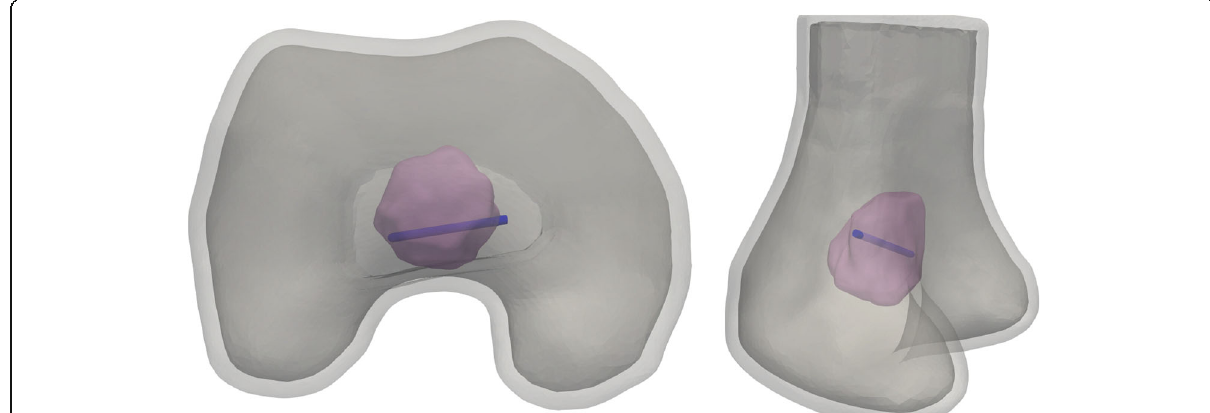
Fig. 3 Example of the resulting three-dimensional models from the image segmentations. The electrode is shown in blue, the tumour in pink, and the bones in different shades of grey. The model corresponds to the case shown in Fig. 1